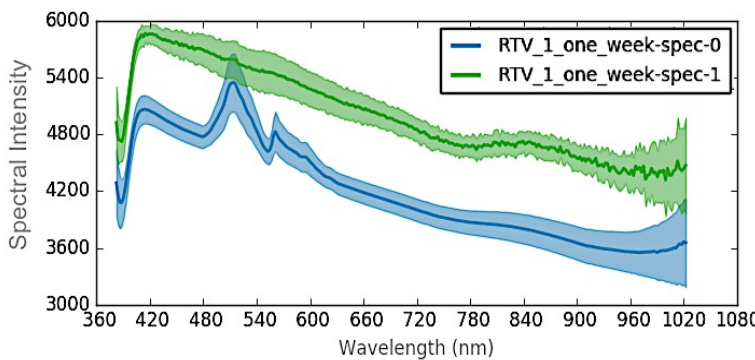
Figure 7. Wavelength plot for RTV-2 (blue) and RTV-2 low molecular weight oil (green).